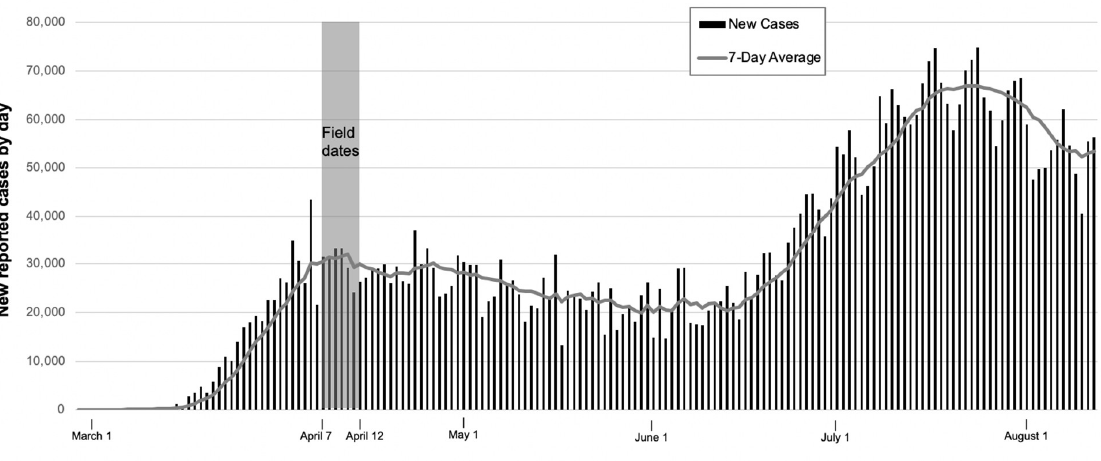
Figure 1. Daily reported COVID-19 cases in the United States. Source: Centers for Disease Control and Prevention, "New Cases by Day.".